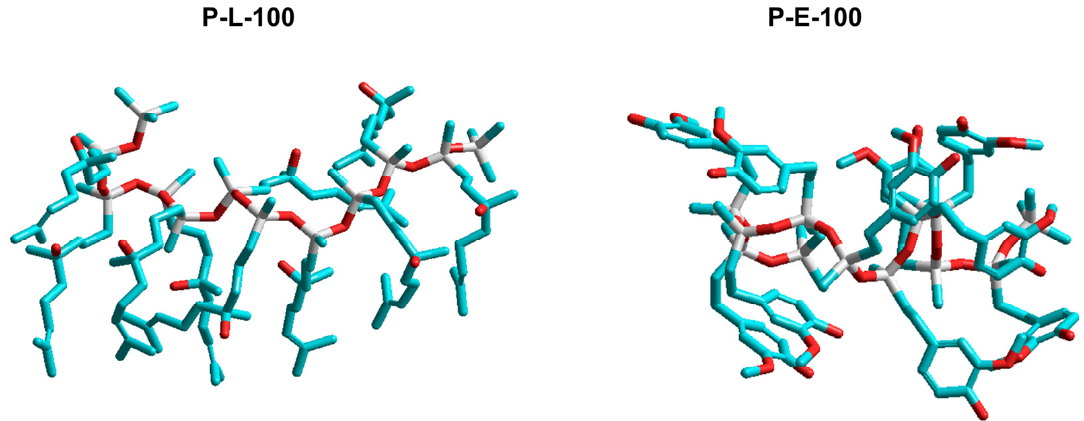
Figure 4. HyperChem calculated structures for P-L-100 and P-E-100 composed of 10 siloxane units. DSC curves of both linalool derivatives showed that the studied samples started to decompose at temperatures higher than 100 ◦ C during the second heating run that was extended to 150 ◦ C. Polymers with side 2-methoxyphenol-4-propyl groups were stable within this temperature range. The differences in thermal stability of the obtained polymeric products were also shown by thermogravimetric analysis (TGA) under a nitrogen atmosphere at a temperature ramp of 10 ◦ C/min (Figure 5). The 5% weight loss temperature (T d5% ) and peak temperature of weight loss derivative (T d1 ) was determined for all the modified polysiloxanes as well as their inorganic and organic precursors (Table 1). Grafting both eugenol and linalool to siloxane macromolecules significantly increased the